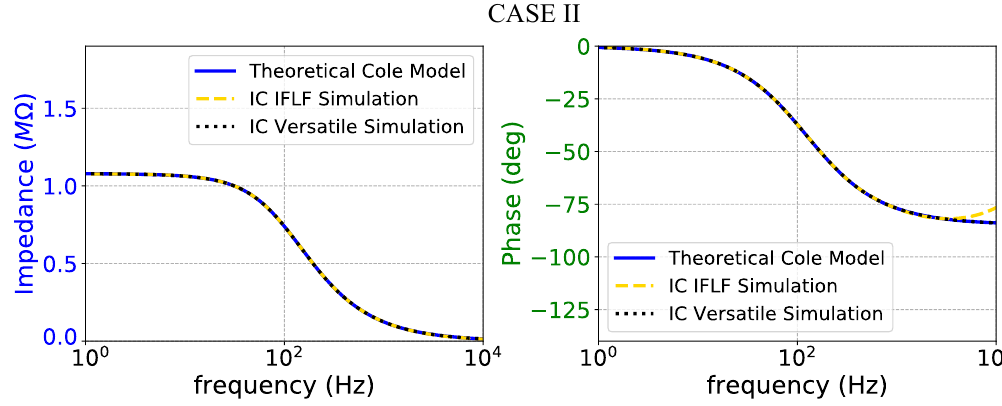
Figure 16. Impedance magnitude ( left ) and phase response ( right ) of the case II fractional-order electrode